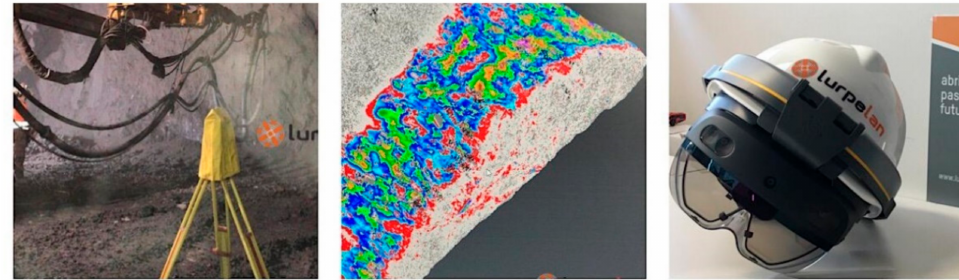
Figure 13. Detail of operations associated with the SHOTCRETE project. Scanning during the gunning operation ( left ) and data viewing ( centre and right ).